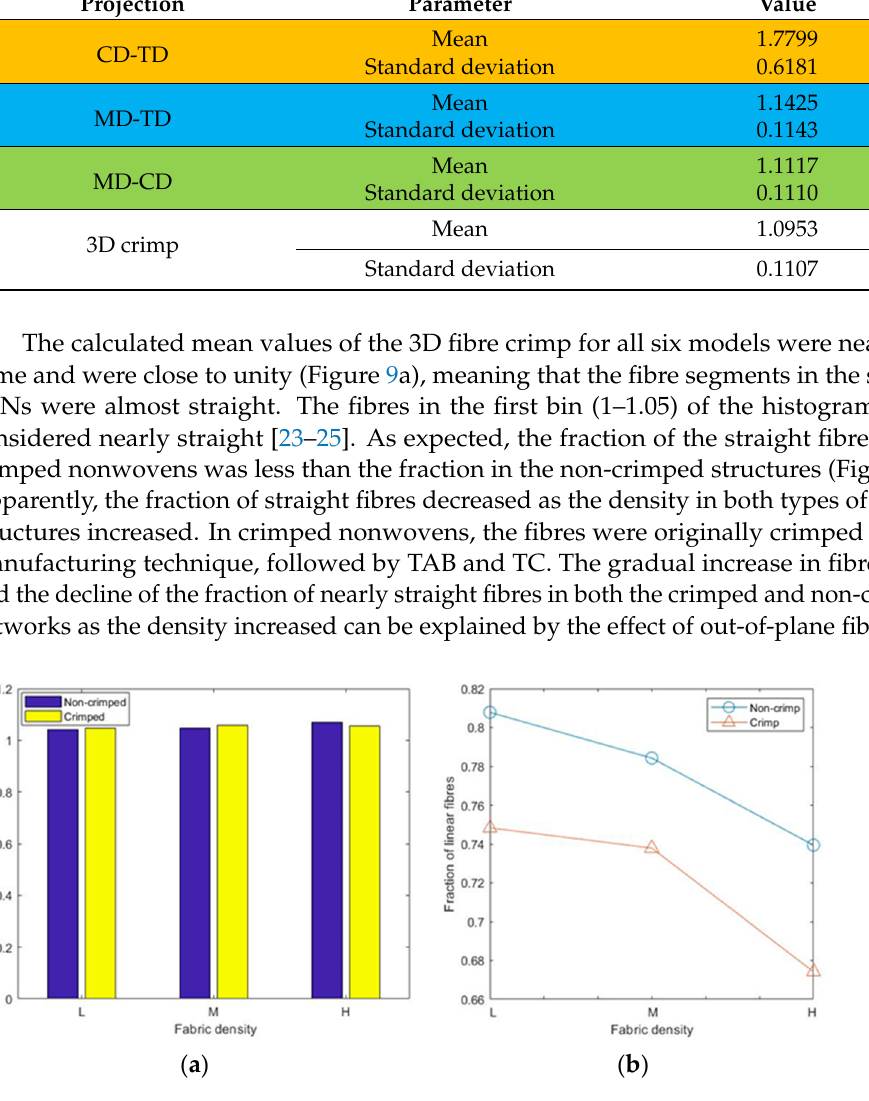
( a ) ( b ) Figure 10. Fibre crimp results: ( a ) minimum values and ( b ) maximum values. Table 4. Average statistical values of X-ray µCT models. Projection